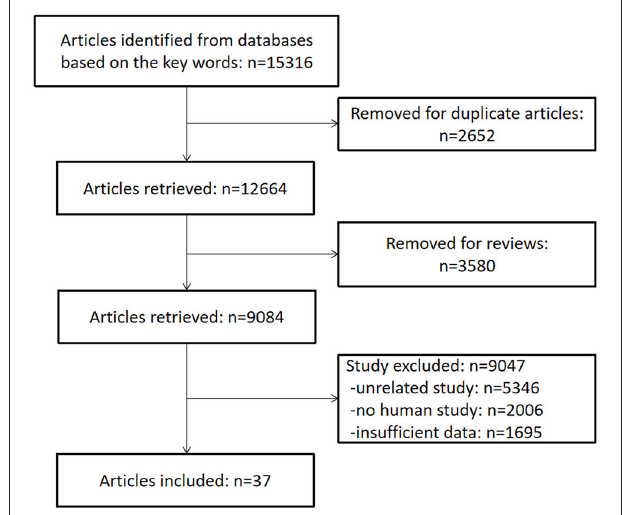
FIGURE 1 | Flow diagram of the literature